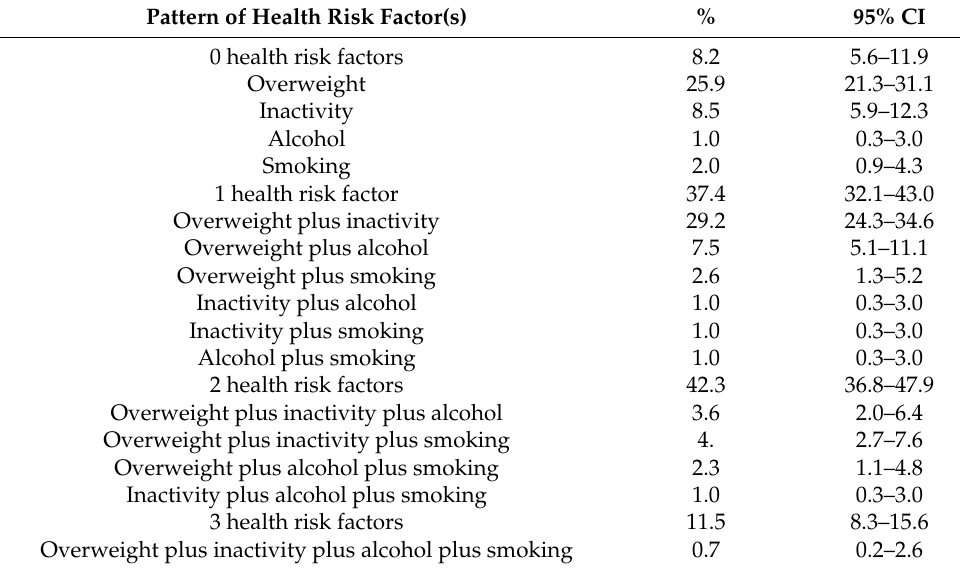
Table 3. Patterns of behavioral health risk factors in the total sample ( n = 305).